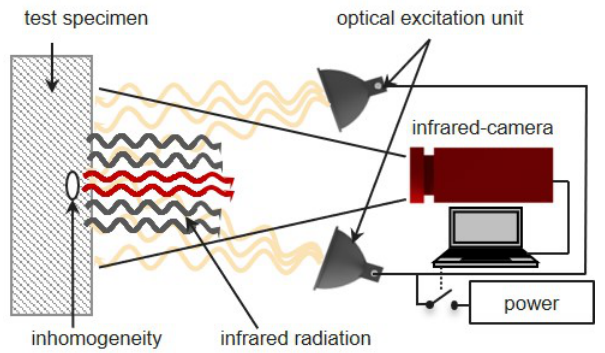
Figure 1. Schematic representation of long-pulse thermography in reflection